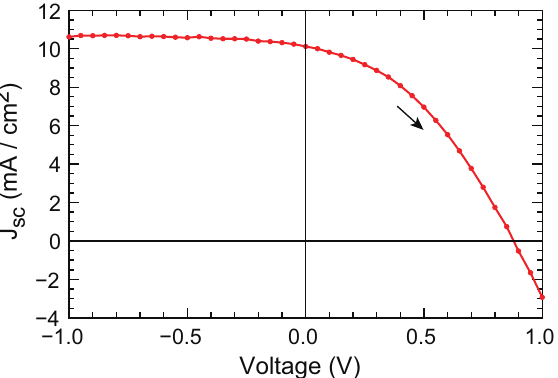
Figure 2. Two-probe forward-scan I–V characteristics of the perovskite solar cell. The red circles indicate each measurement